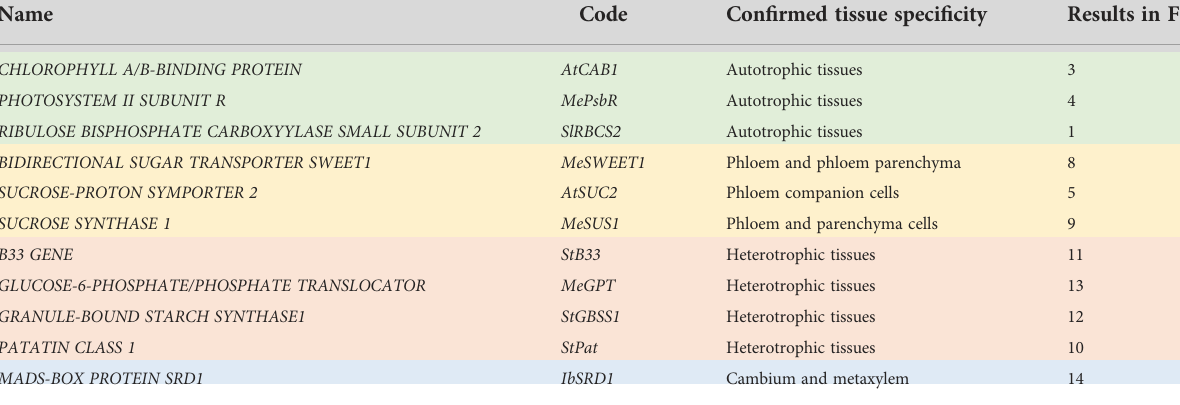
TABLE 3 Promoter recommendations for target